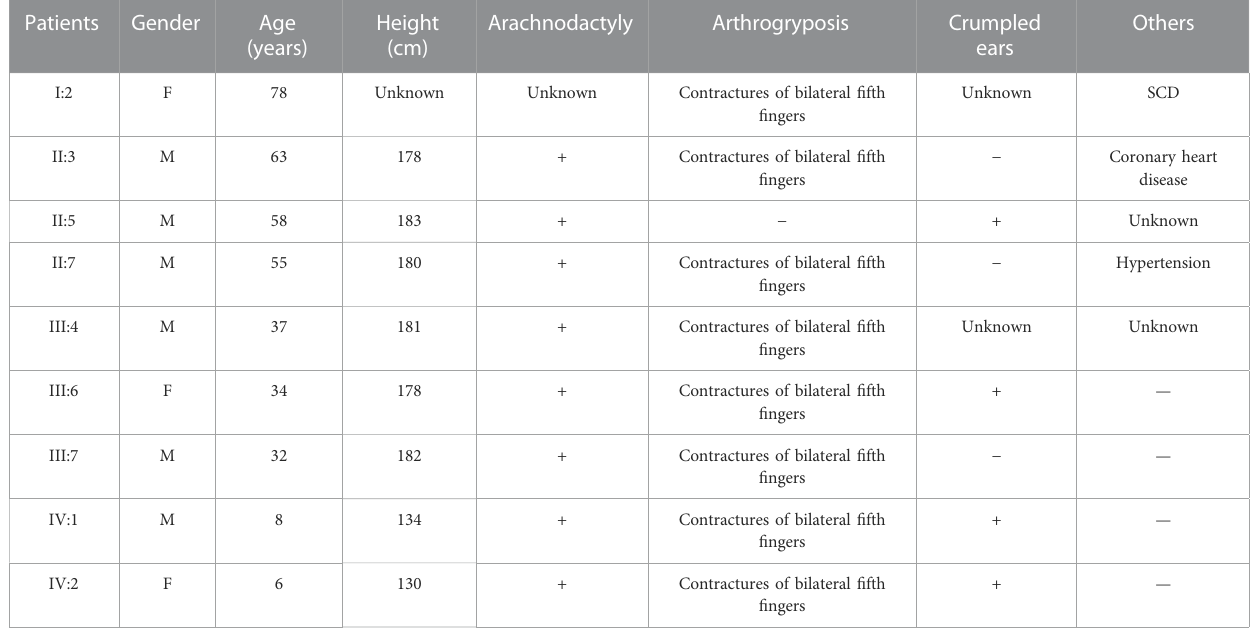
TABLE 1 Phenotypes of those affected in the F1 family.